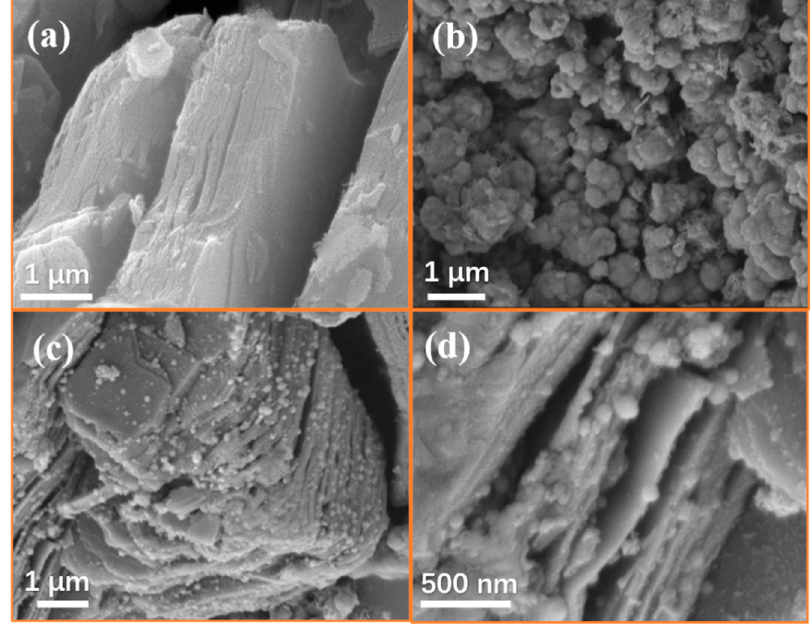
Figure 4. Scanning electron microscopy (SEM) of Ti 3 C 2 T x ( a ), CoS nanoparticles ( b ), CoS@Ti 3 C 2 T x composite ( c , d ).